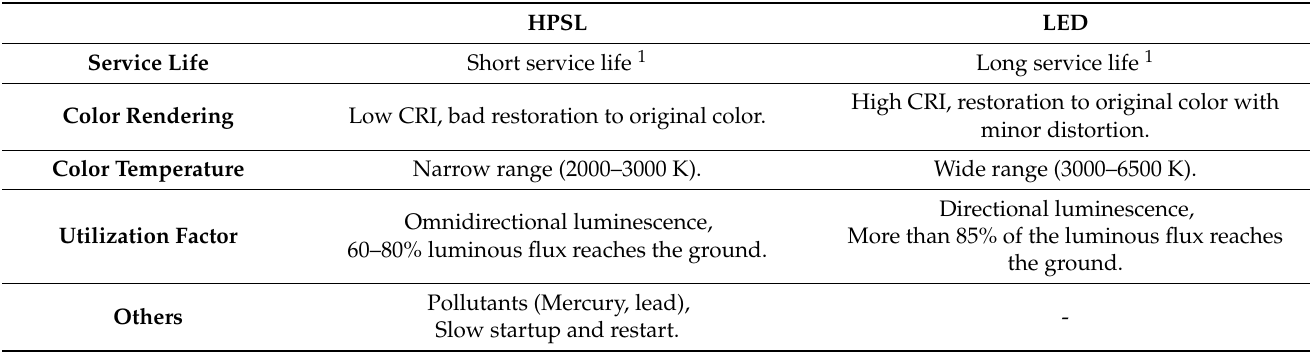
Table 2. Comparison of HPSL and